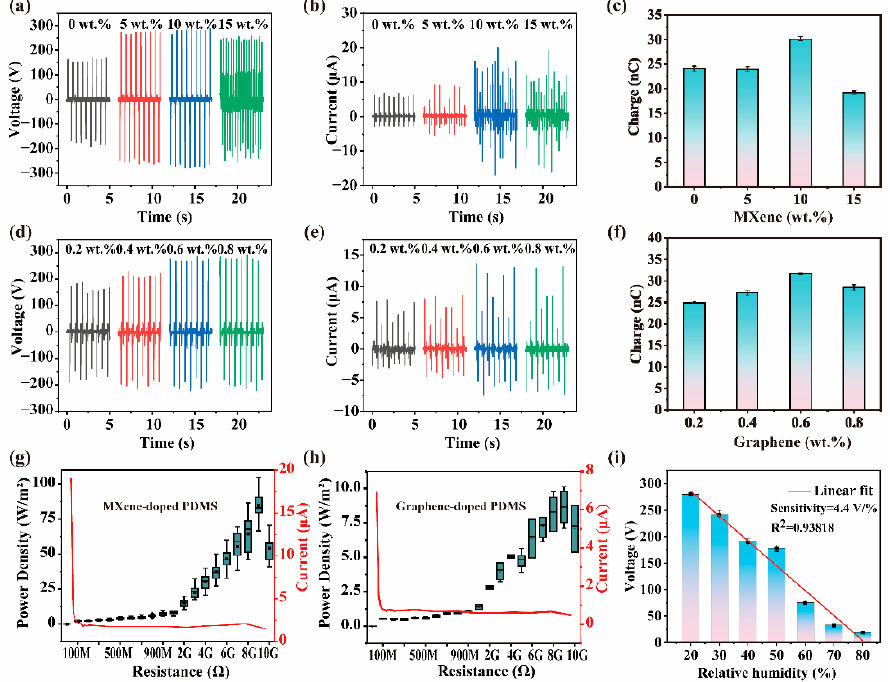
Figure 3. ( a – c ) Outputs for the LLB TENGs with varying the mass ratio of MXene in the structured MXene-doped PDMS film. ( d – f ) Outputs for the LLB TENGs with varying the mass ratio of graphene in the structured graphene-doped PDMS film. Power density and current curves under different load resistance for ( g ) MXene-doped PDMS film and ( h ) graphene-doped PDMS film. ( i ) Output voltage of the MXene-doped LLB TENG as a function of the RH of the ambient environment.